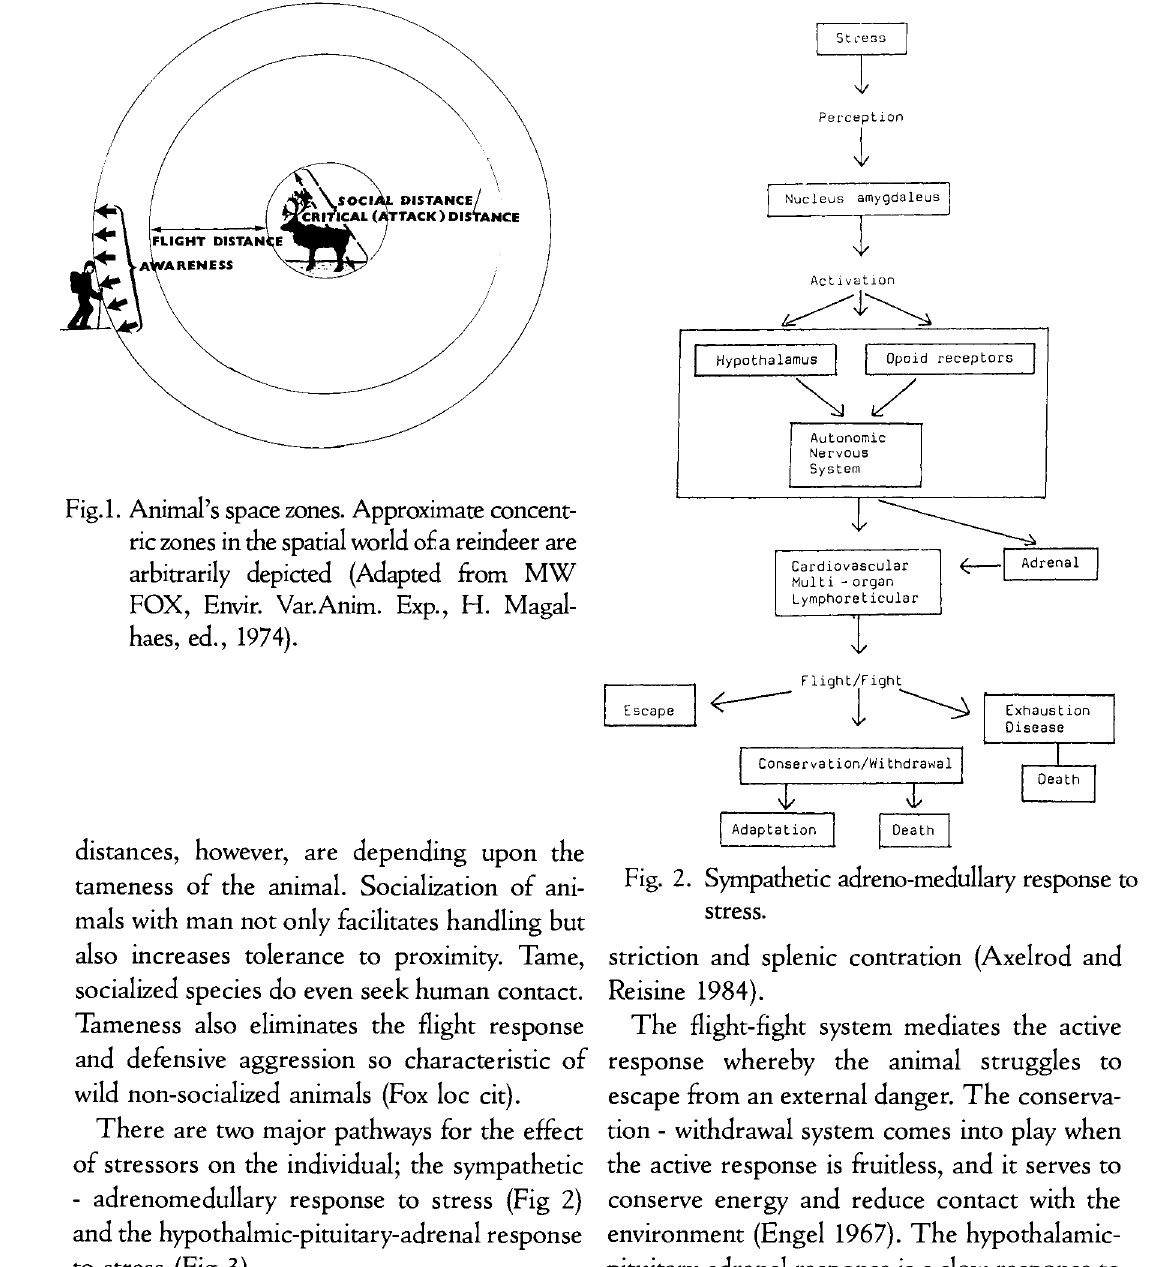
Fig. 2. Sympathetic adreno-medullary response to